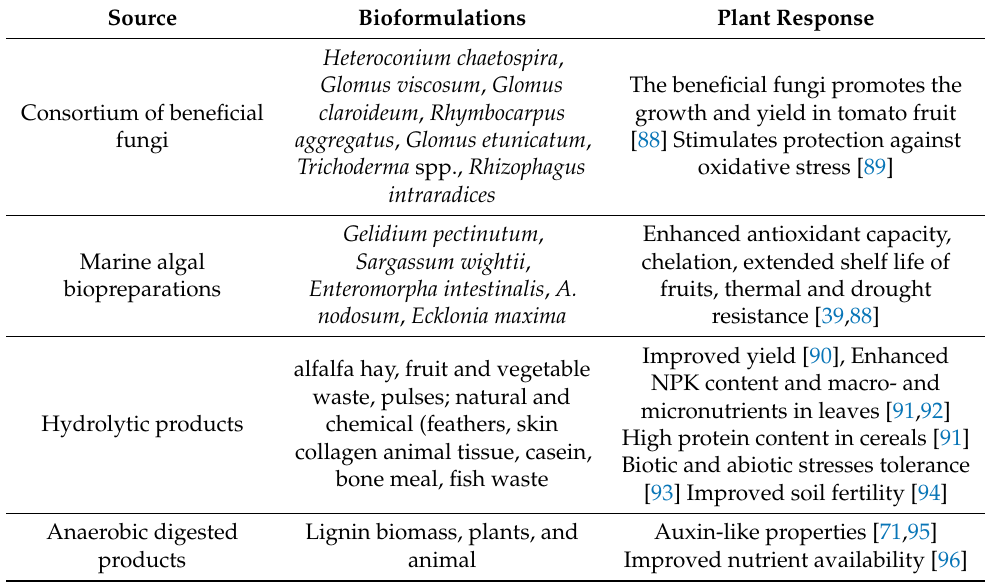
Table 3. Effect of biostimulants on plant metabolic and physiological